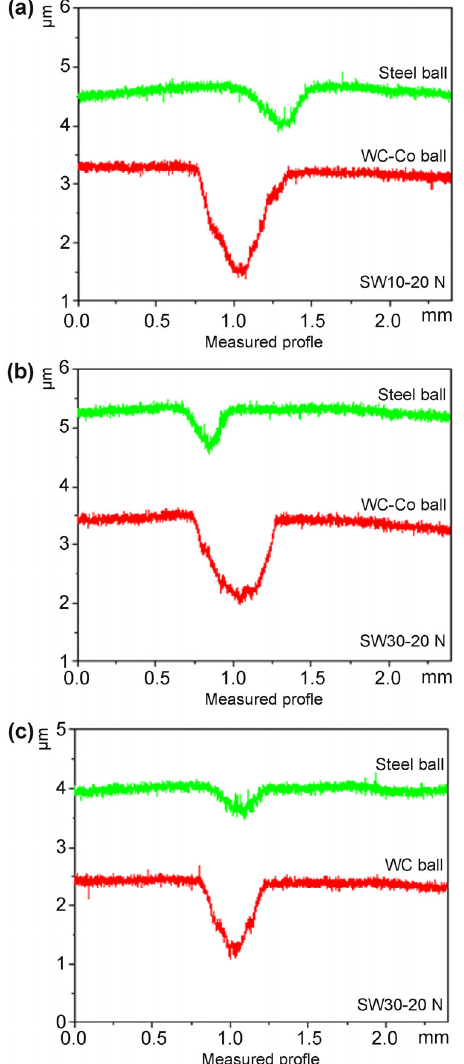
Fig. 4 Typical surface profile of wear scar on monolithic SiC ceramics at (a) 5 N, (b) 10 N and (c) 20 N, against WC-Co and steel counterbodies.